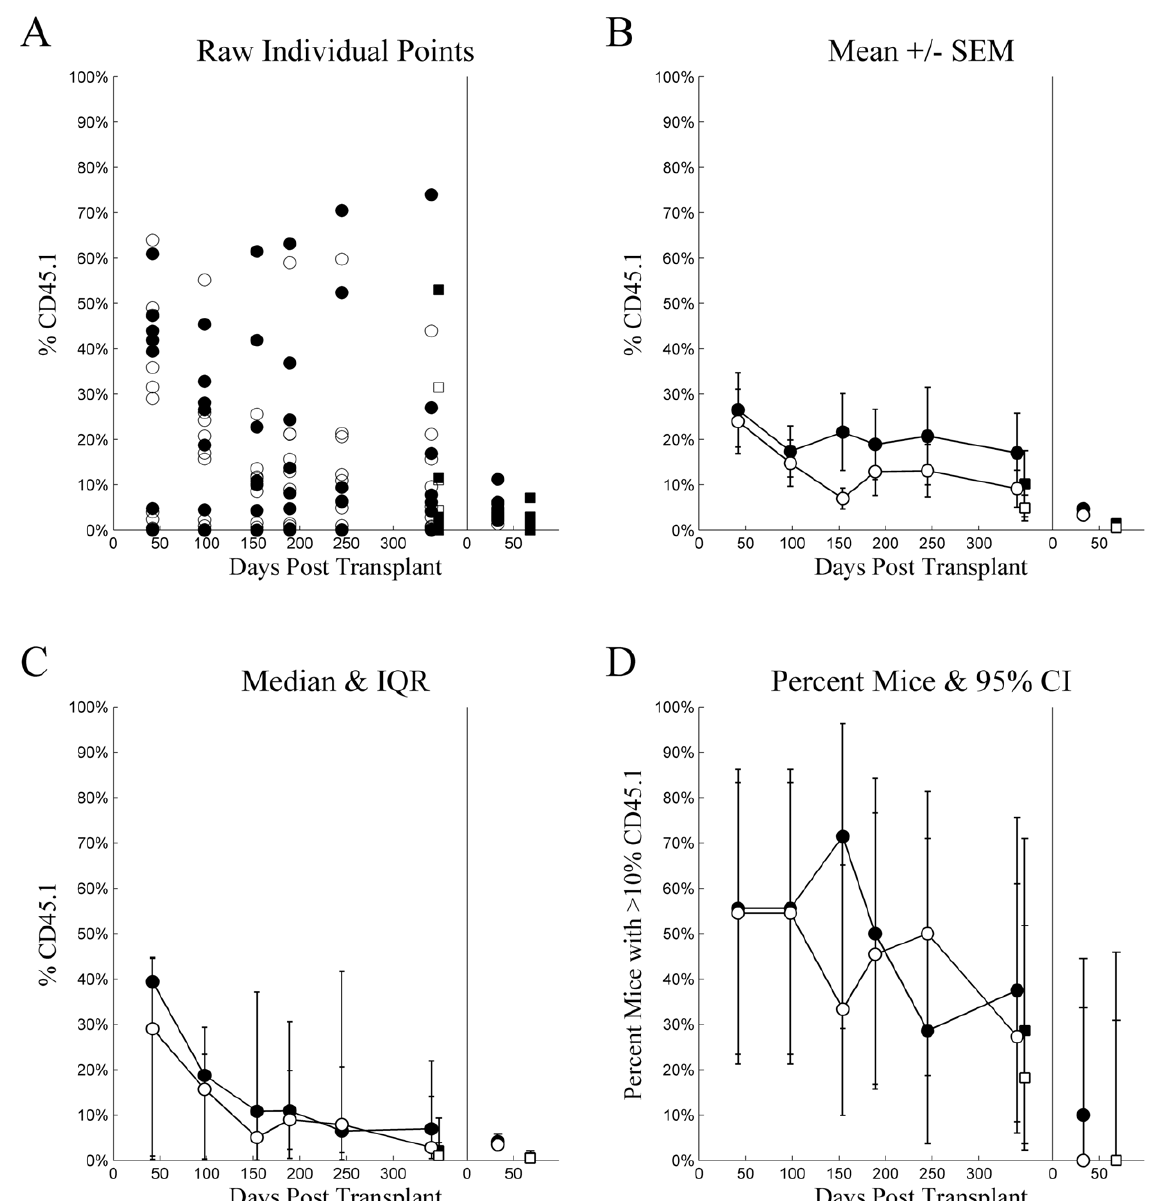
N N Figure 5. Experiment 2: intrafemoral injection. Chimerism (%CD45.1) (ordinate) plotted as a function of Days Post Transplant (abscissa), type of & : LT-HSC, #% : ST-HSC), and source ( # : whole blood, &% : whole bone marrow) for several different methods of summary: A) cells injected ( raw individual mouse percent CD45 cells that were CD45.1, B) mean 6 standard error of the mean, C) median with inter-quartile range, and D) percent of mice with greater than 10% of CD45 cells being CD45.1. For each tile, the data from the primary transplant is plotted on the left and secondary transplant on the right, separated by a vertical line at zero for the secondary transplant.